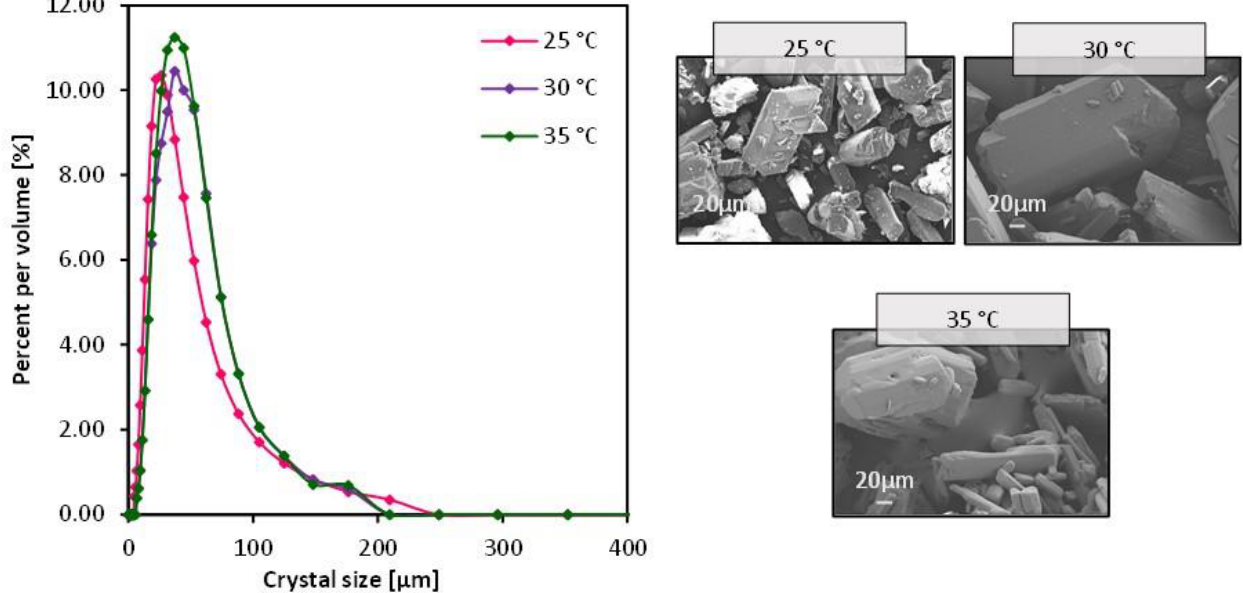
Figure 7. SEM images of crystals obtained from the bulk solution after MAAC operation and the corresponding crystal size distribution, with variation of temperature from 25 to 35 °C.